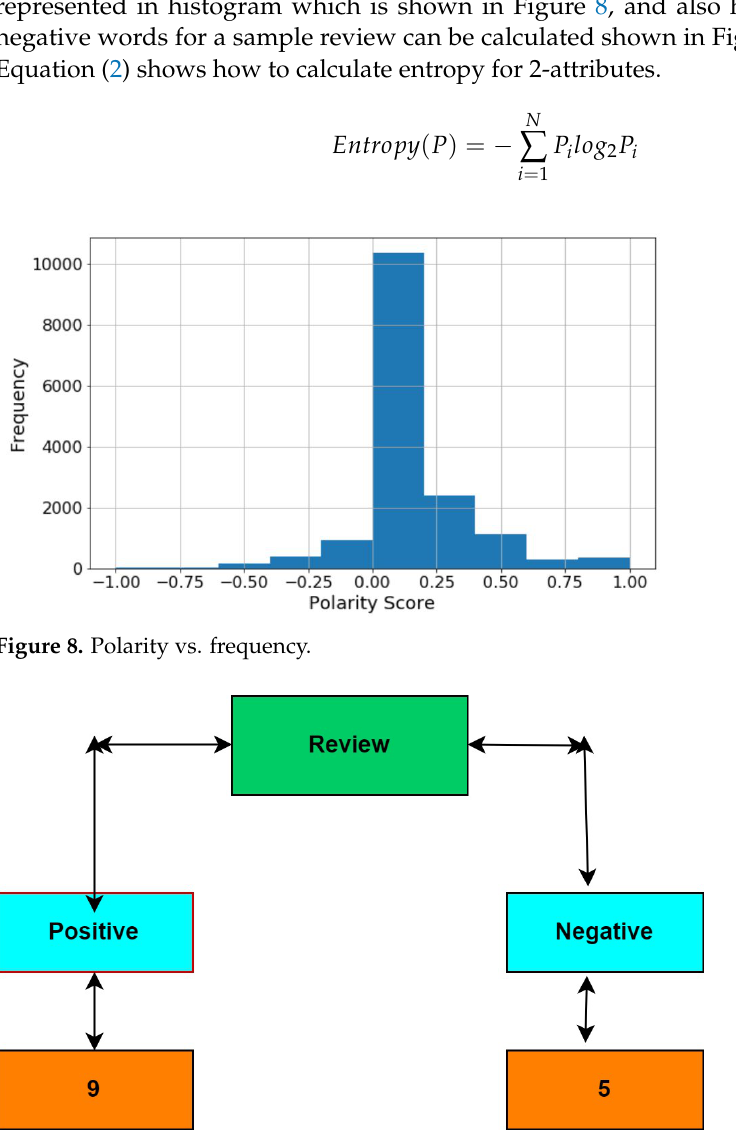
Figure 9. Finding positive and negative words for Sample